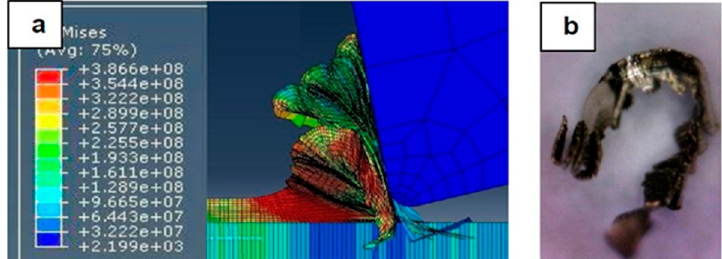
Figure 9. Machining Stainless Steel 316L at feed rate 0.03 mm/rev: ( a ) Chip formation and ( b ) produced chip.